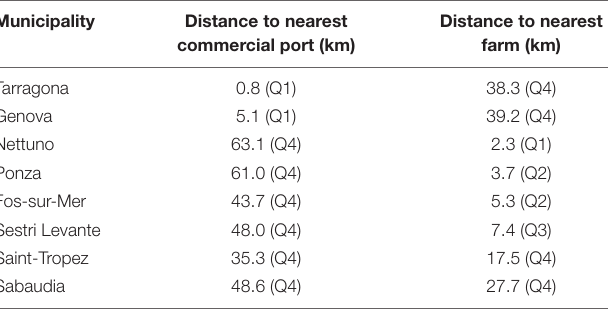
TABLE 2 | Municipalities which present atypical values for distance to the nearest fish farm or commercial